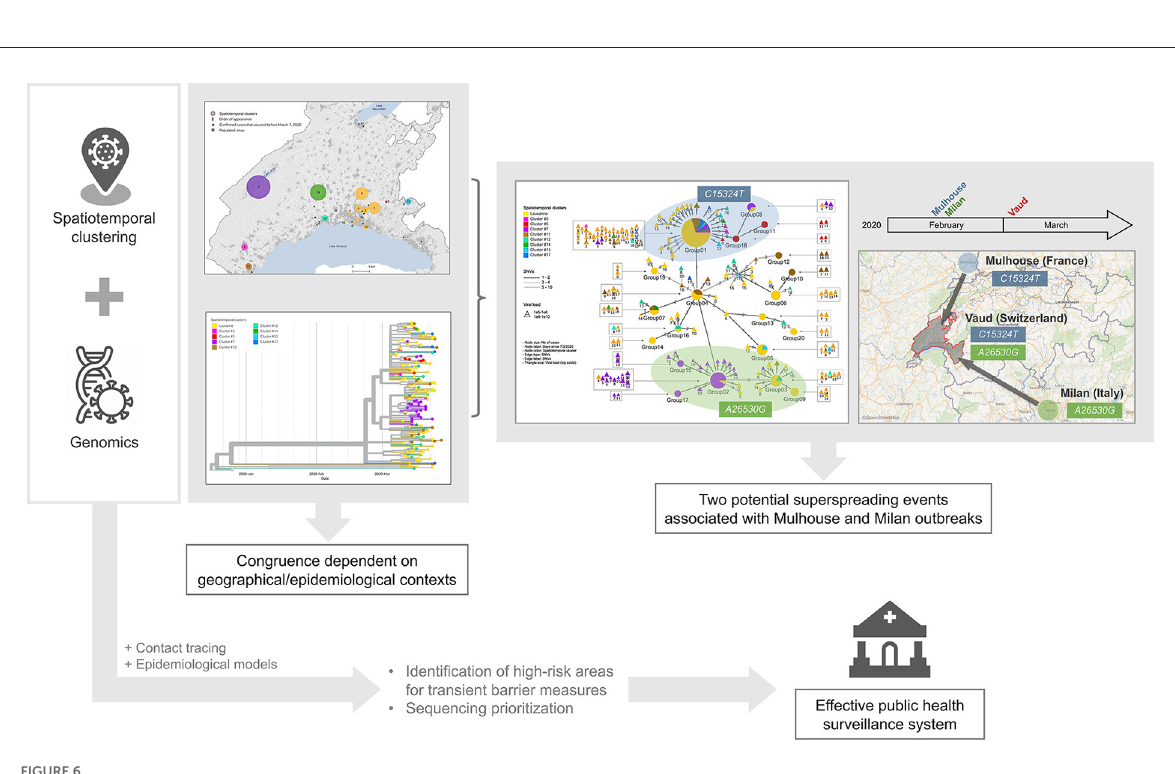
FIGURE6 Graphical representation of findings and